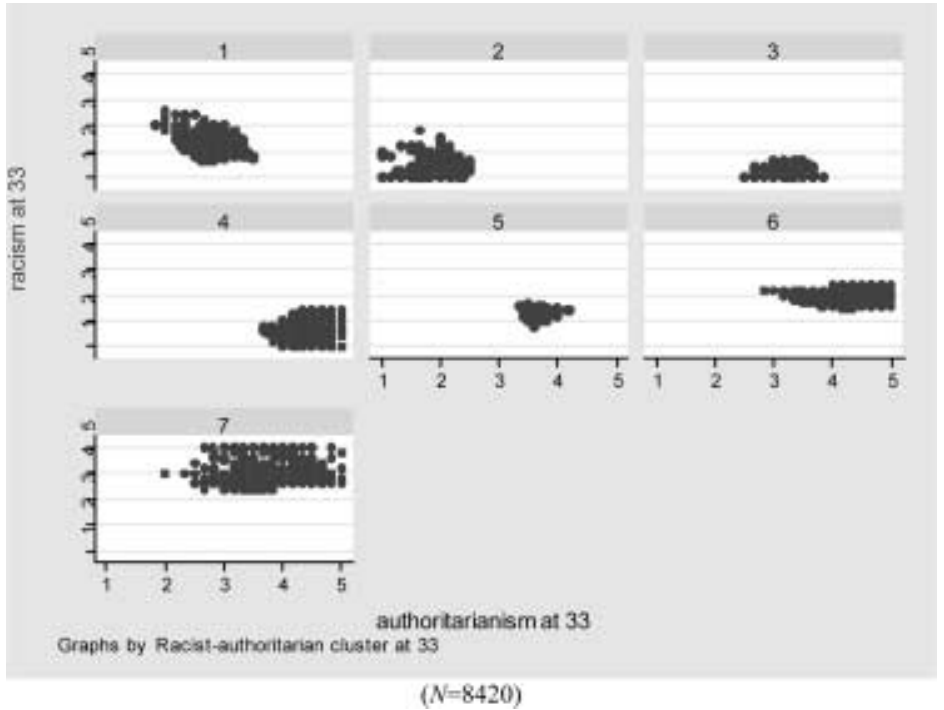
Figure 1. Cluster analysis of racism/authoritarianism at age